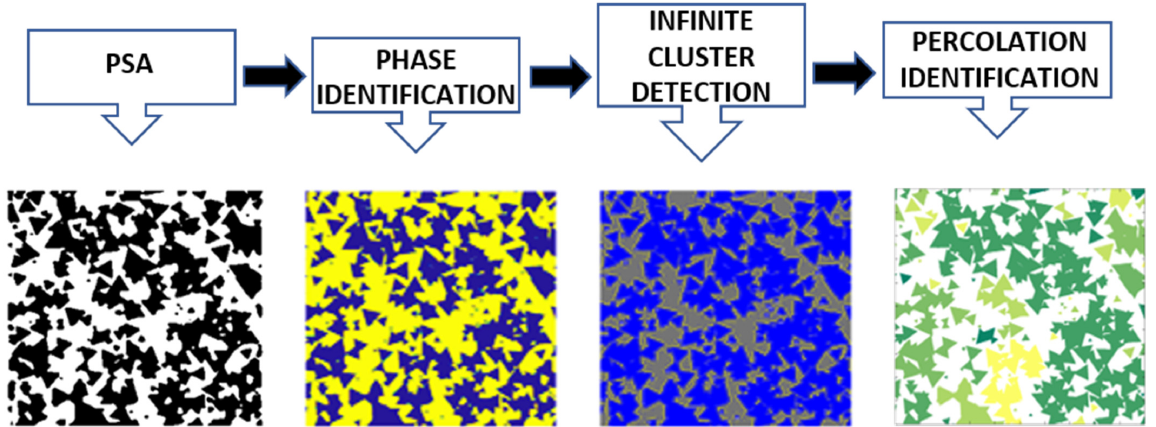
Figure 9. Percolation process for infinite cluster detections.